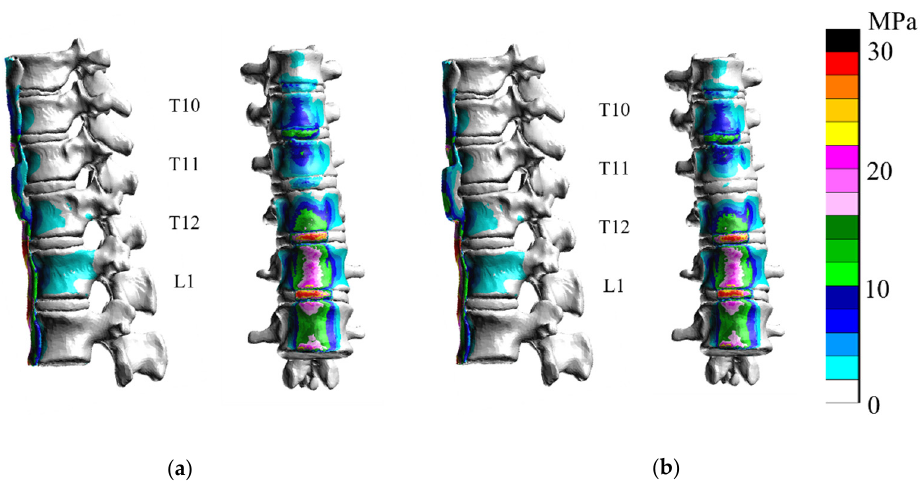
Figure 7. In extension analyses of the hypertrophic ossification models T-5 ( a ) and T-10 ( b ), the stress on the intervertebral disc at T11–T12 was reduced, whereas stress on the vertebral body was un- changed.